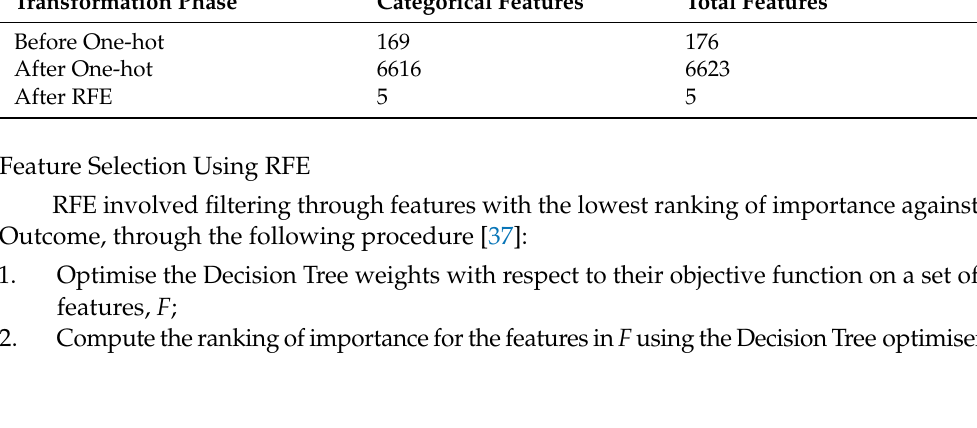
Table 2. Background data feature count per phase of transformation. Transformation Phase